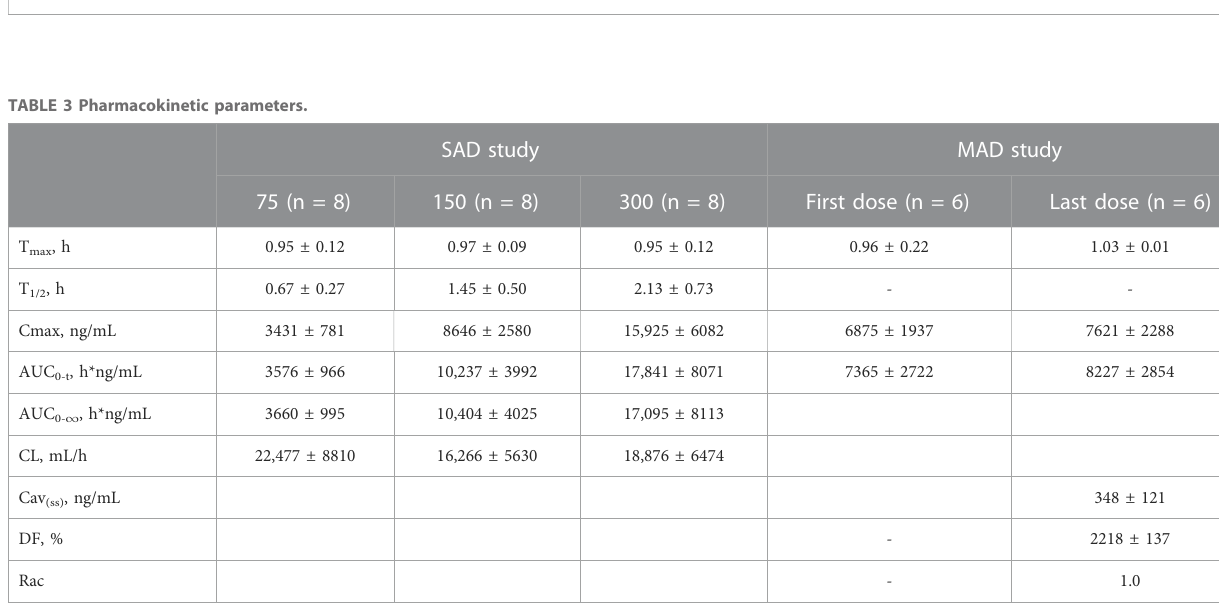
FIGURE 3 Plasma concentration – time pro fi le of salvianolic B in the MAD study. n = 6. Data are presented as the mean ± SD.